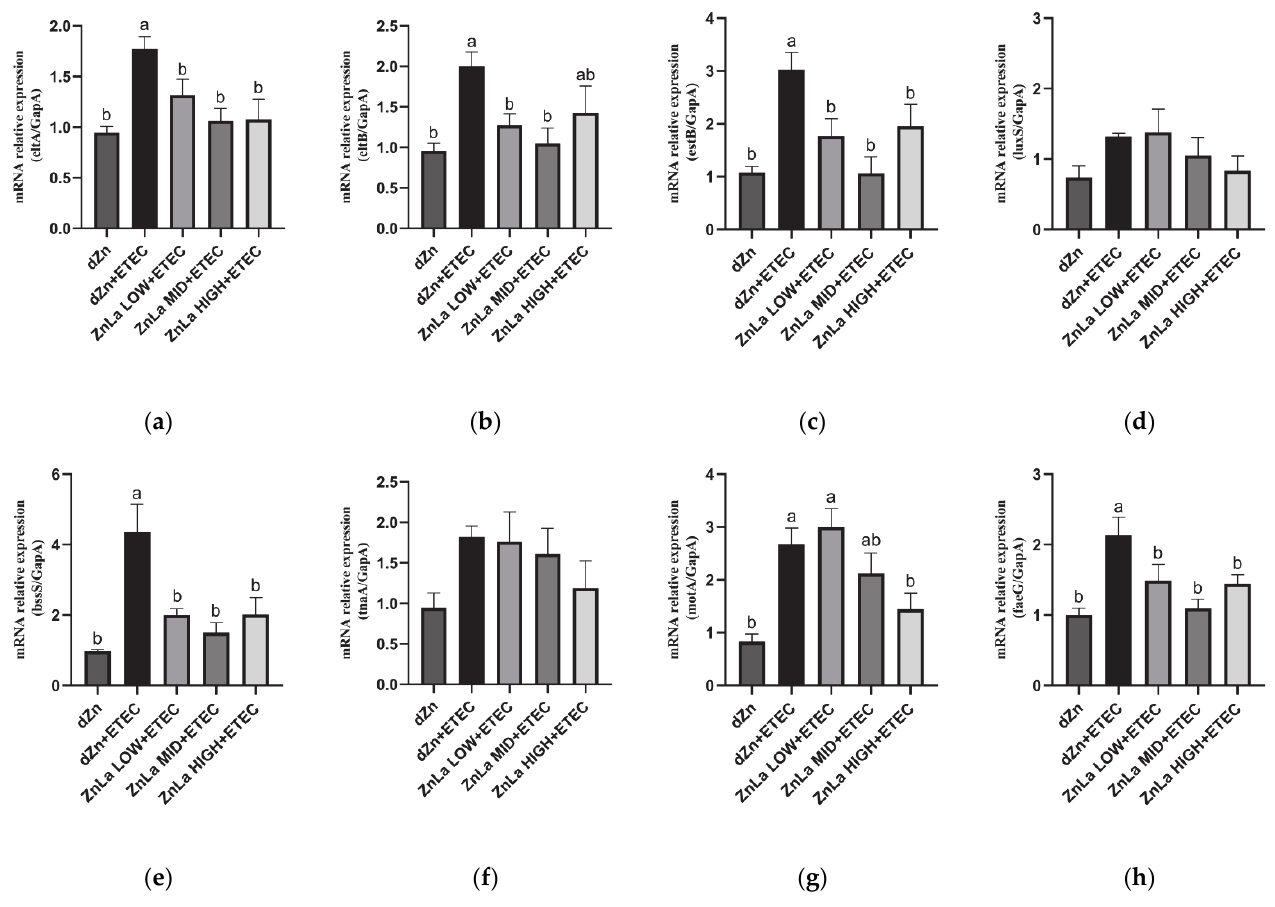
Figure 8. Effects of ZnLa on the relative expression of virulence factors in the cecal content of mice with ETEC infection. ( a , b ) LT (eltA and eltB), ( c ) ST (estB), ( d ) quorum sensing (luxS), ( e , f ) biofilm formation (bssS and tnaA), ( g ) motility (motA), and ( h ) cellular adhesion (faeG). The data are expressed as mean ± s.e.m (n = 9), and different lowercase letters in each group show significant differences ( p < 0.05).